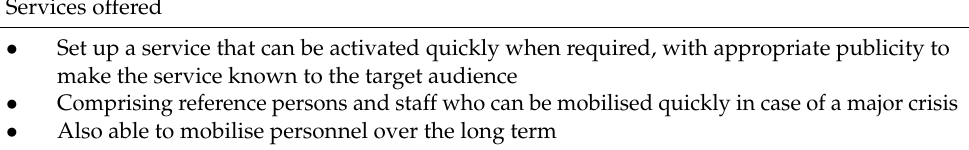
Table 3. Proposals for future improvements to mental health support service